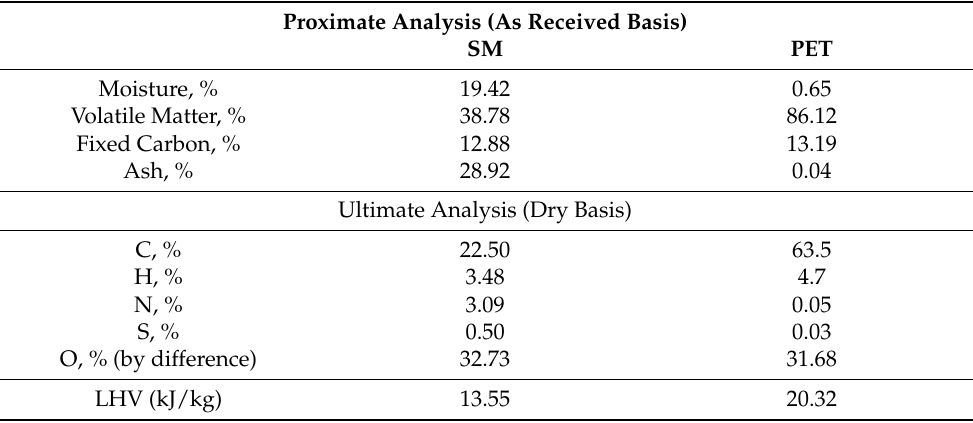
Figure 1. Photograph of raw materials ( a ) SM, ( b ) PET. In Table 1, the proximate and elemental analyses of the samples are shown. Moisture, volatile matter, and ash contents of the feedstock were determined by ASTM D3173, ASTM D 3175, ASTM D 3174, respectively. The major elements (C, H, N, S) were detected by the LECO CHNS-932 elemental analyzer, and the content of O was calculated by the difference. The calorific value of the samples was determined in the LECO AC-350 Bomb Calorimeter. Table 1. Proximate and ultimate analyses of